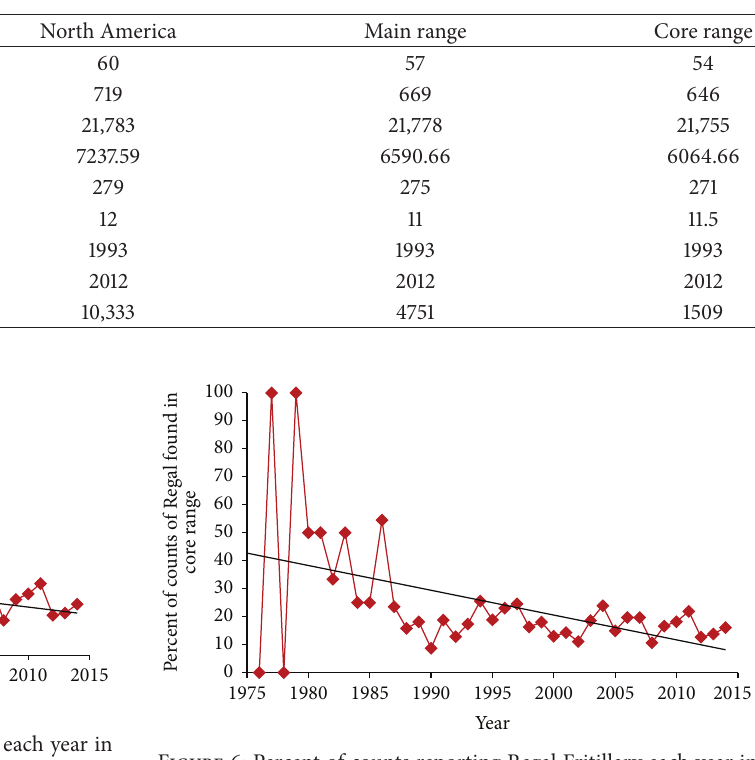
Figure 6: Percent of counts reporting Regal Fritillary each year in core Regal range, 1977–2014, with regression trend line. This decline was significant in 1977–2014 but not in 1991–2014 (Table